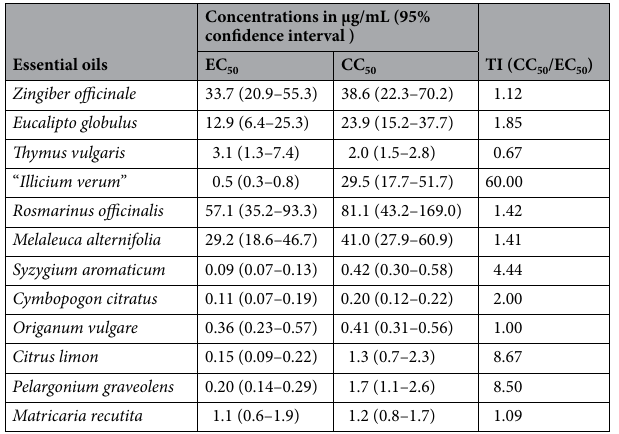
Table 1. In vitro antiviral and cytotoxic activities of twelve essential oils expressed in half-maximal effective concentration (EC 50 ), half-maximal cytotoxic concentration (CC 50 ), and therapeutic index